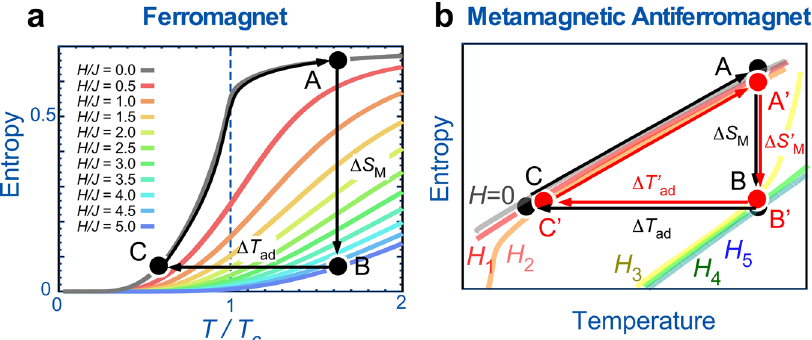
Fig. 1 Comparison between conventional ferromagnet and antiferromagnet with a metamagnetic phase transition in entropy − temperature diagram. a Thermal variation of magnetic entropy change in typical magnetic fi elds ( H ) from H / J = 0 to H / J = 5.0 (where J is the ferromagnetic exchange constant) for ferromagnetic cases simulated in a previous theoretical study in ref. 30 . The temperature is normalized to the Curie temperature T C . b Schematic illustration of magnetic refrigeration (MR) cycle for the case of antiferromagnetic (AFM) material that shows a metamagnetic phase transition. Magnetic fi elds are represented by zero fi eld μ H = 0 and fi nite fi elds H H H H H 0 1 < 2 < 3 < 4 < 5 . For the AFM case in b , the metamagnetic phase transition occurs over a small magnetic fi eld change, Δ H = ∣ H 2 − H 3 ∣ , during the MR cycle A ′ → B ′ → C ′ → A ′